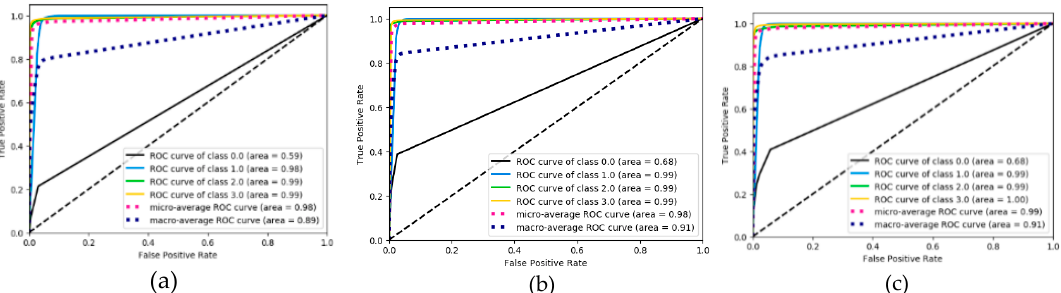
Figure 11. ROC curve performance derived from LSTM + CNN classification under three pace settings: 0.78 m / s ( a ), 1.0 m / s ( b ) and 1.25 m / s classes ( c ).